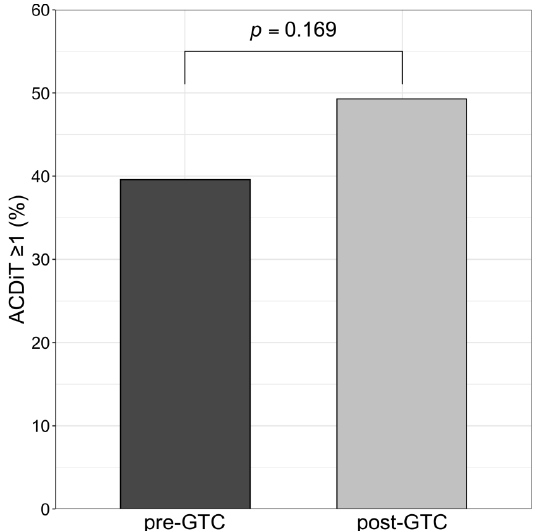
Figure 1. Necessity of deviation from initial management plans due to in-hospital course complica- tions as indicated by the Adapted Clavien – Dindo Scoring System in Trauma (ACDiT). The percent- age of patients with an ACDiT ≥1 was not significantly different between groups. GTC, Geriatric Trauma